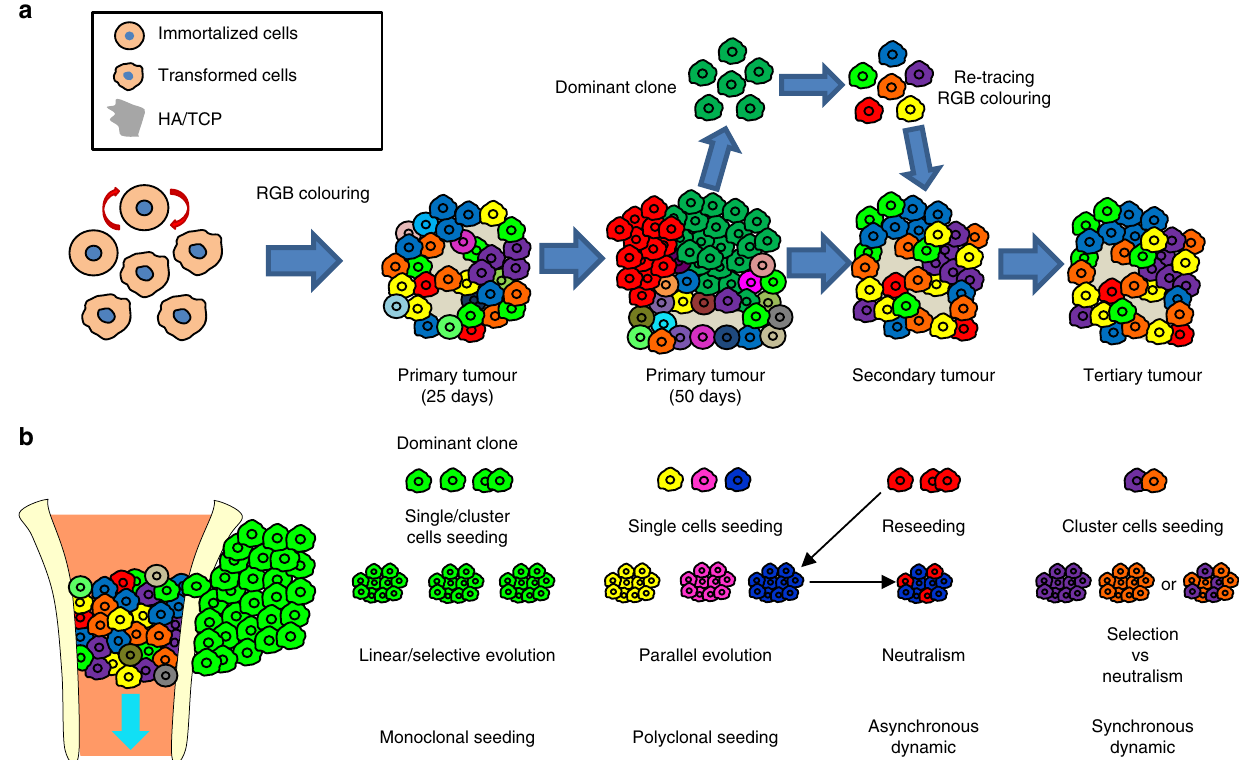
Fig. 7 Schematic representation of the clonal dynamics in osteosarcomagenesis. a Schematic model of ectopic OS generated by transformed MPCs; the model indicates clonal heterogeneity over time; the fi rst level of neutral evolution is typical of tumours at 25 days of development; clonal equilibrium is maintained until the development of different locally dominant clones in the extracompartmental region at 50 days. Dominant clones are sub-clonally heterogeneous and establish tumour development through a new level of neutral coexistence in secondary and tertiary transplantation. b Schematic model of OS developing at orthotopic location (left) and metastatic disease (right). Note the clonal heterogeneity in the medullary space and the outgrowth of locally dominant clones (one is depicted for simpli fi cation). On the right, the possible clonal dynamics of metastatic seeding are indicated; changes in colonization strategy (single cells vs. cluster), evolution models (selection vs. parallel vs. neutralism), clonality (monoclonality vs. polyclonality), and timing (synchronous vs. asynchronous) of the process are indicators of the possible clonal origin and the fi nal clonal composition of metastatic nodules. Our model presents evidence of parallel evolution and polyclonal synchronous seeding